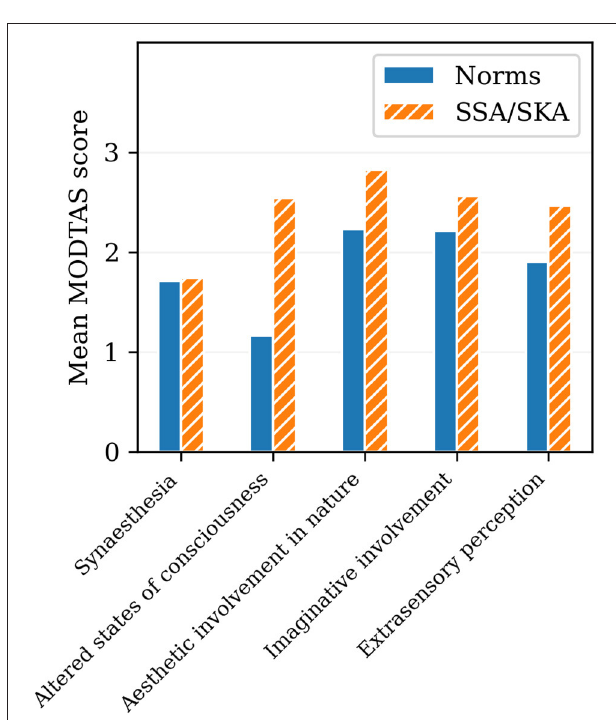
FIGURE 2 | Bar chart comparing the mean subscale scores of the Modified Tellegen Absorption Scale (MODTAS; Jamieson, 2005) for the published “normal” population (Norms; N = 352; Jamieson, 2005) and for the participants of this study (SSA/SKA; N = 152).